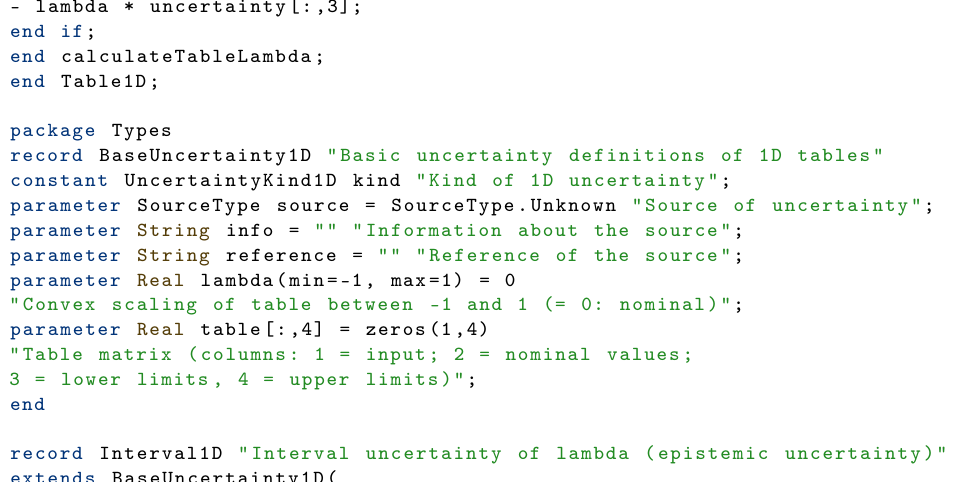
else table[:,2] := (1 + lambda) *